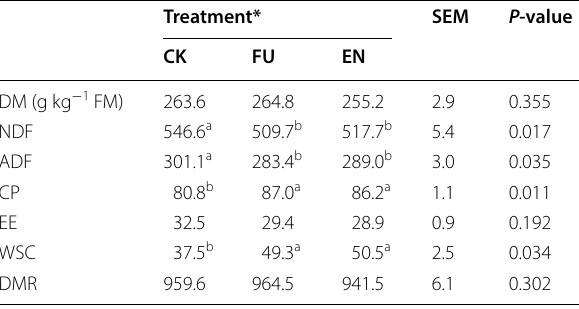
Table 4 Effects of different additive treatments